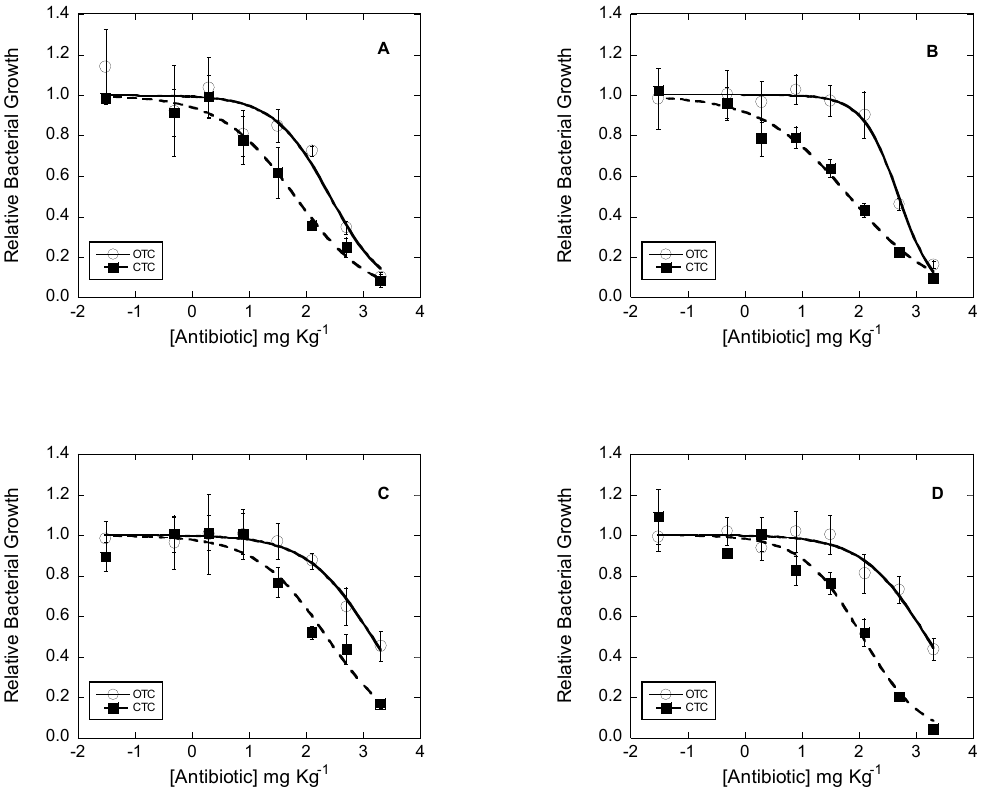
Figure 3. Comparison of oxytetracycline (OTC) and chlortetracycline (CTC) toxicity for four soils (used as example) after 1 incubation day. ( A – D ) represent soil samples 1, 9, 12 and 22 (Table S1, Supplementary material).